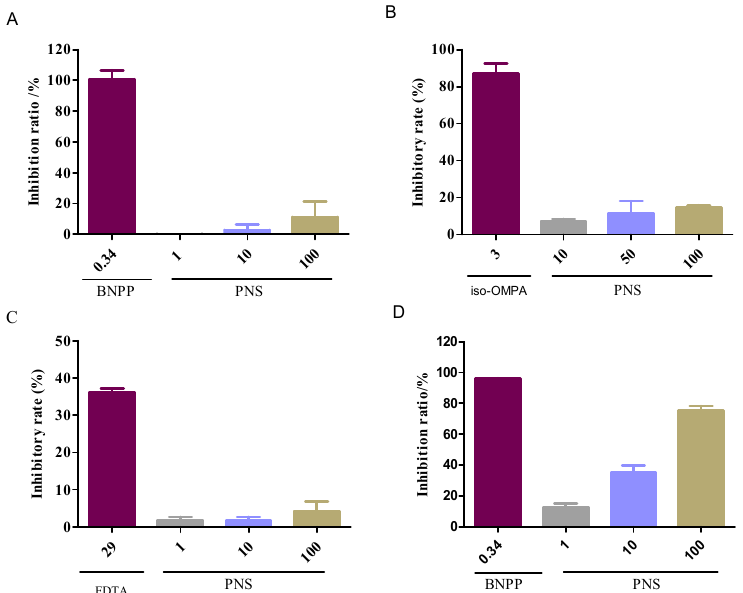
Figure 2. Inhibitory effects of PNS toward the esterases of hCE1, BChE, PON and hCE2 ( A – D in order) with BMBT (2-(2-benzoyloxy-3-methoxyphenyl)benzothiazole), FD (Fluorescein diacetate), BuSCh (S-Butyrylthiocholine chloride) and PA (phenyl acetate) as a highly selective substrate of each esterase. BNPP, iso-OMPA, and EDTA are well-known inhibitors for hCE1 (hCE2), BChE, and PON, respectively. Data were presented as mean ± SD ( n = 3).